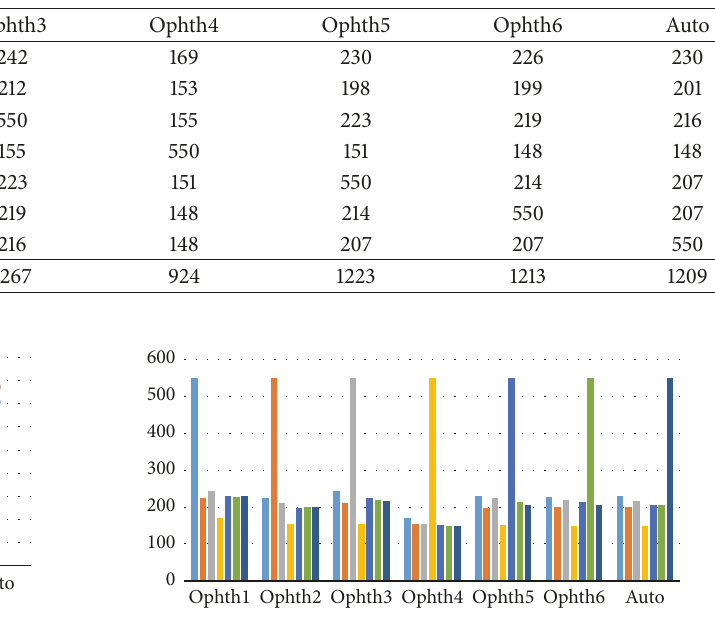
Figure 17: The number of images agreed for the HCDR and VCDR between the ophthalmologists and the algorithm. 𝑥 -axis represents the number of 6 ophthalmologists and the algorithm. 𝑦 - axis represents the number of agreed